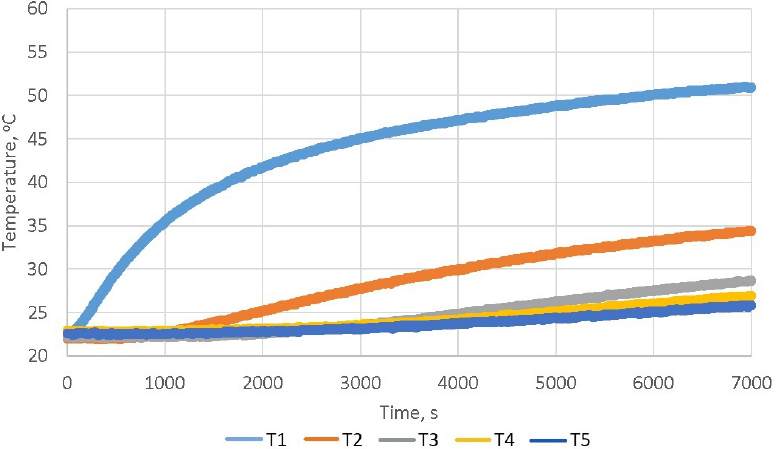
Figure 7. The dependence of the temperature value on the time in individual thermocouples during heating a concrete